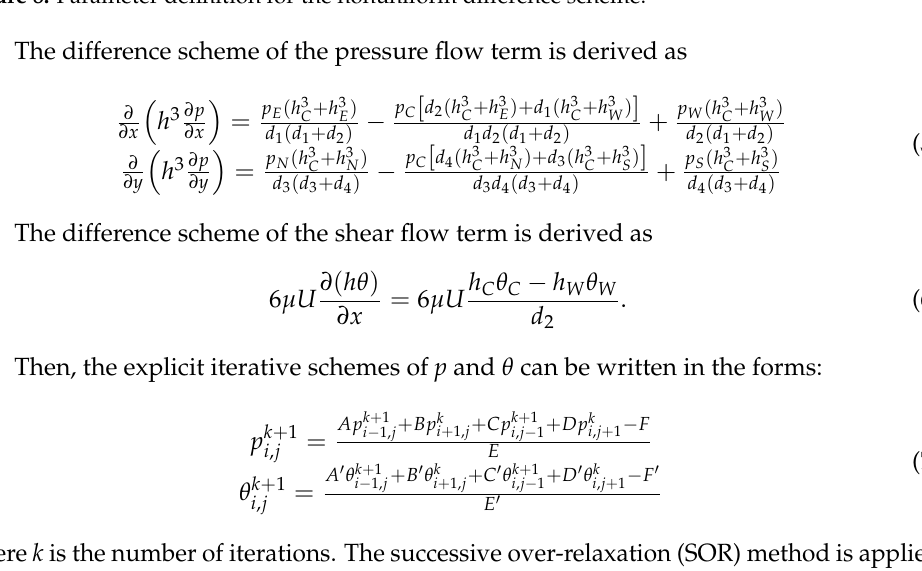
Figure 8. Parameter definition for the nonuniform difference scheme.